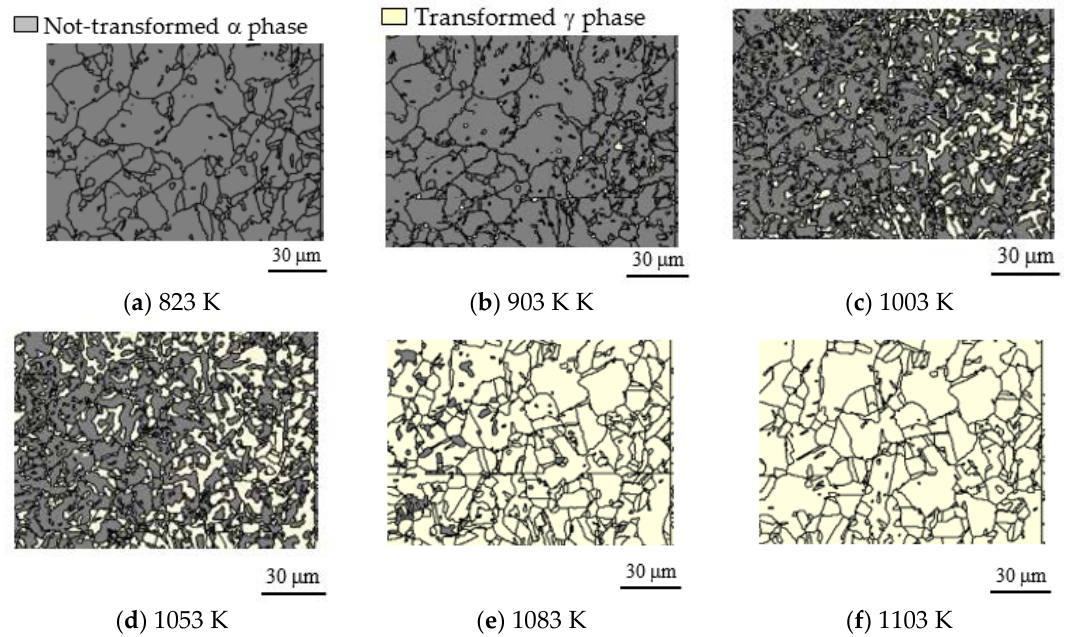
Figure 7. Phase maps of not-transformed α phase and transformed γ phase at 823 K ( a ), 903 K ( b ), 1003 K ( c ), 1053 K ( d ), 1083 K ( e ), and 1103 K ( f ).